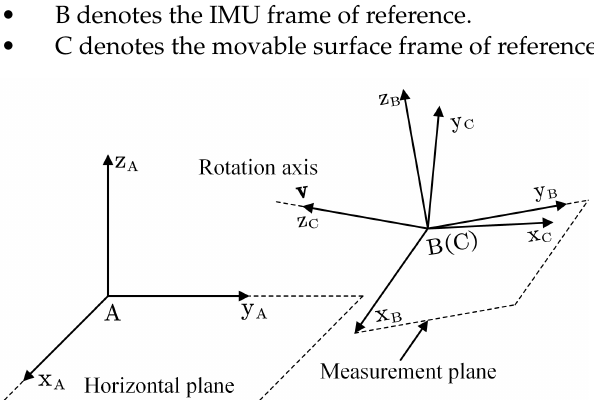
Figure 2. Frames of reference are used. A denotes the frame fixed on the Earth, B denotes the IMU frame of reference, and C denotes the movable surface frame of